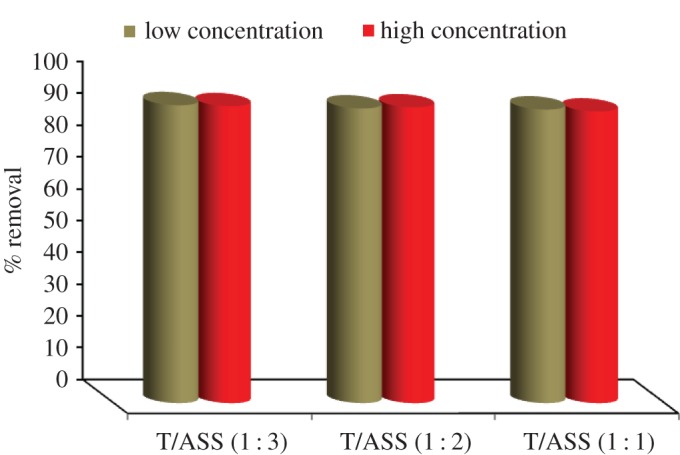
Removal efficiency of Cd2+ by TiO2/ASS (1 : 3, 1 : 2 and 1 : 1) at low and high MO and Cd2
+ initial concentration.